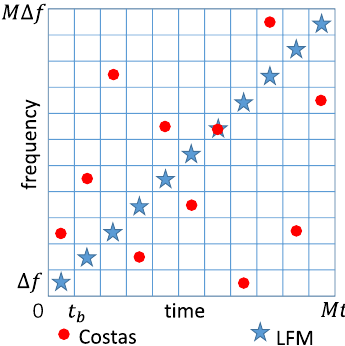
Fig. 5 Costas code: frequency hopping compared with the LFM